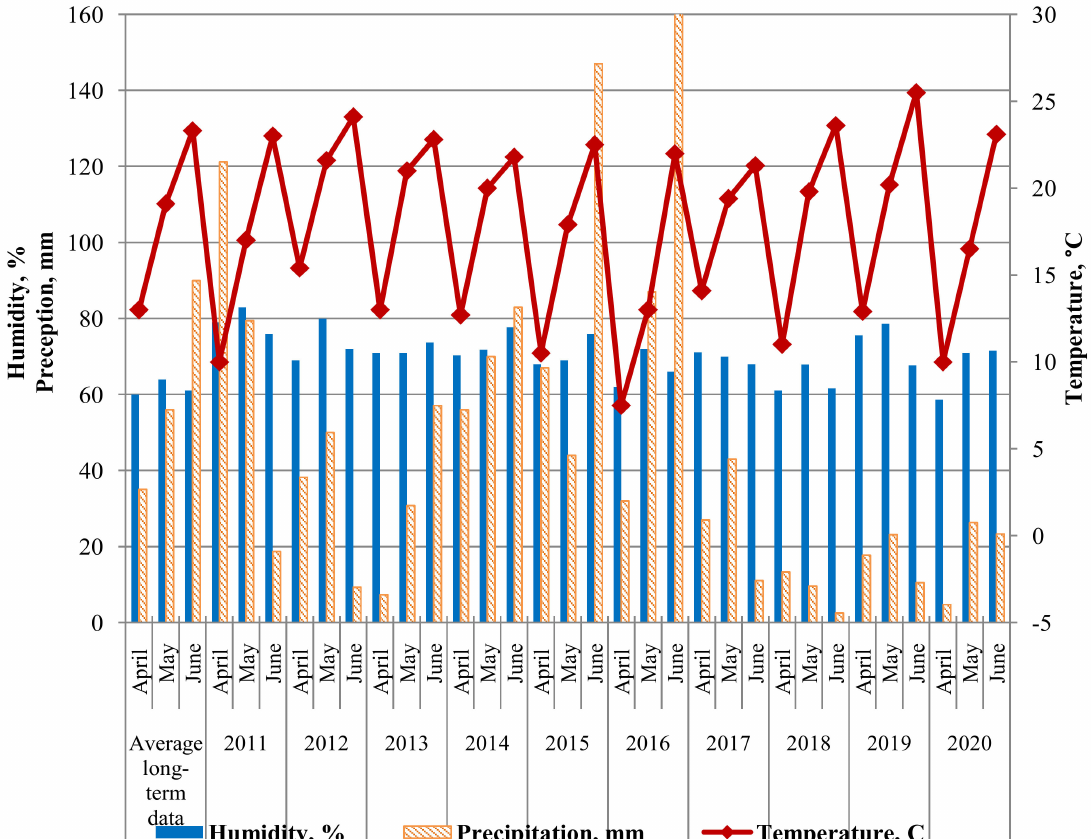
Figure 2. Climatogram of weather conditions for the research period 2011–2020 (according to the FSCBPP meteorological